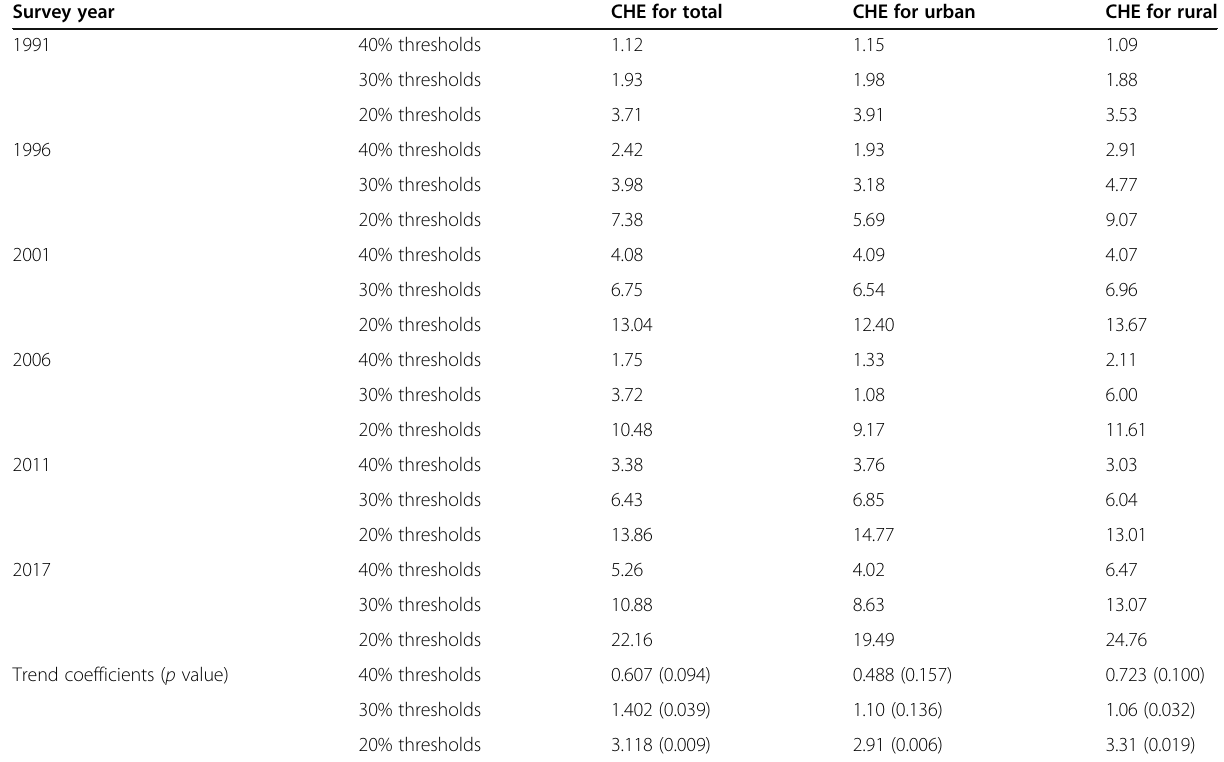
Table 3 Incidence of CHE at the three different levels of the CTP of the households for total, urban, and rural areas over 6 years